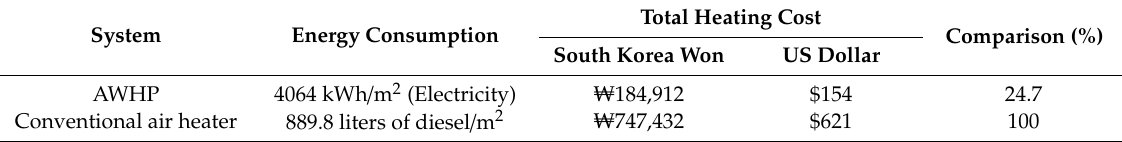
Table 3. Heating cost comparison for the AWHP and a conventional air